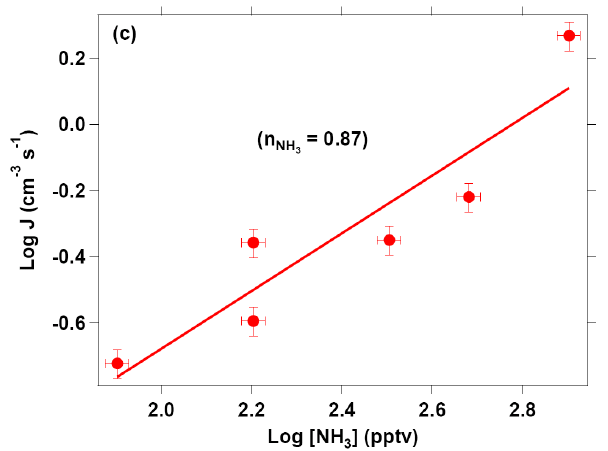
Fig. 3c. The measured Log J vs. Log [NH 3 ] for THN experiments. Figure 3c. The measured Log J vs. Log [NH 3 ] for THN experiments. RH = 8%. [H 2 SO 4 ] = 647 RH=8%. [H 2 SO 4 ]=8 . 2 × 10 6 cm − 3 . Residence time = 170s. 8.2×10 6 cm -3 . Residence time = 170 s. 648